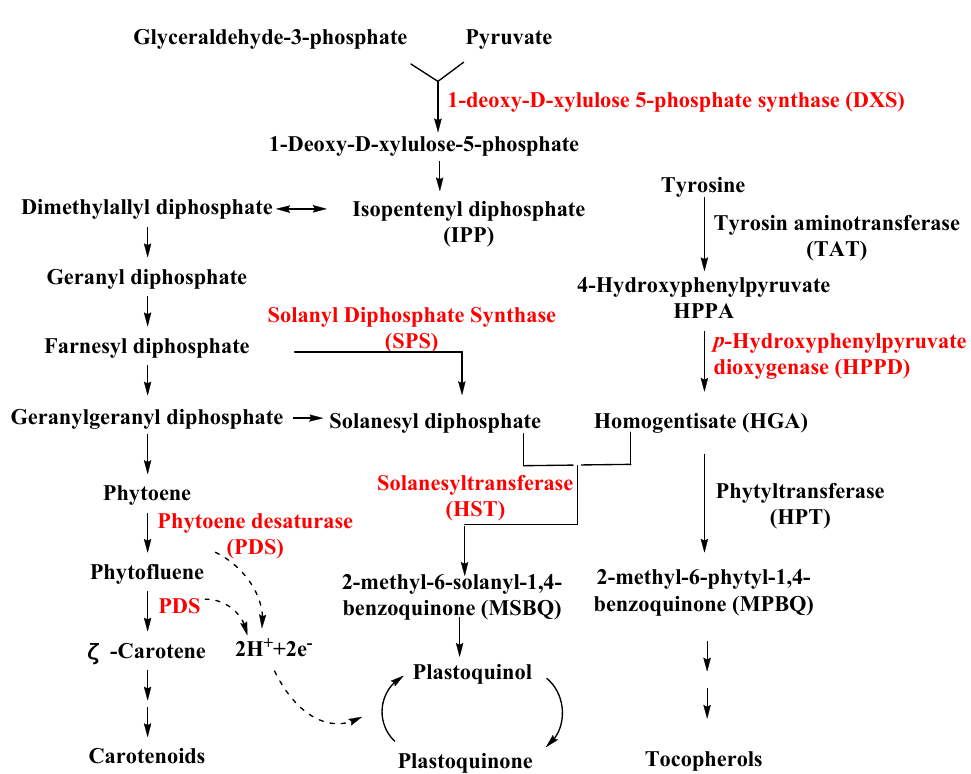
Figure 1. Biosynthesis pathways for carotenoids, plastoquinone, and tocopherols in plant. The herbicide target is indicated by the red color.